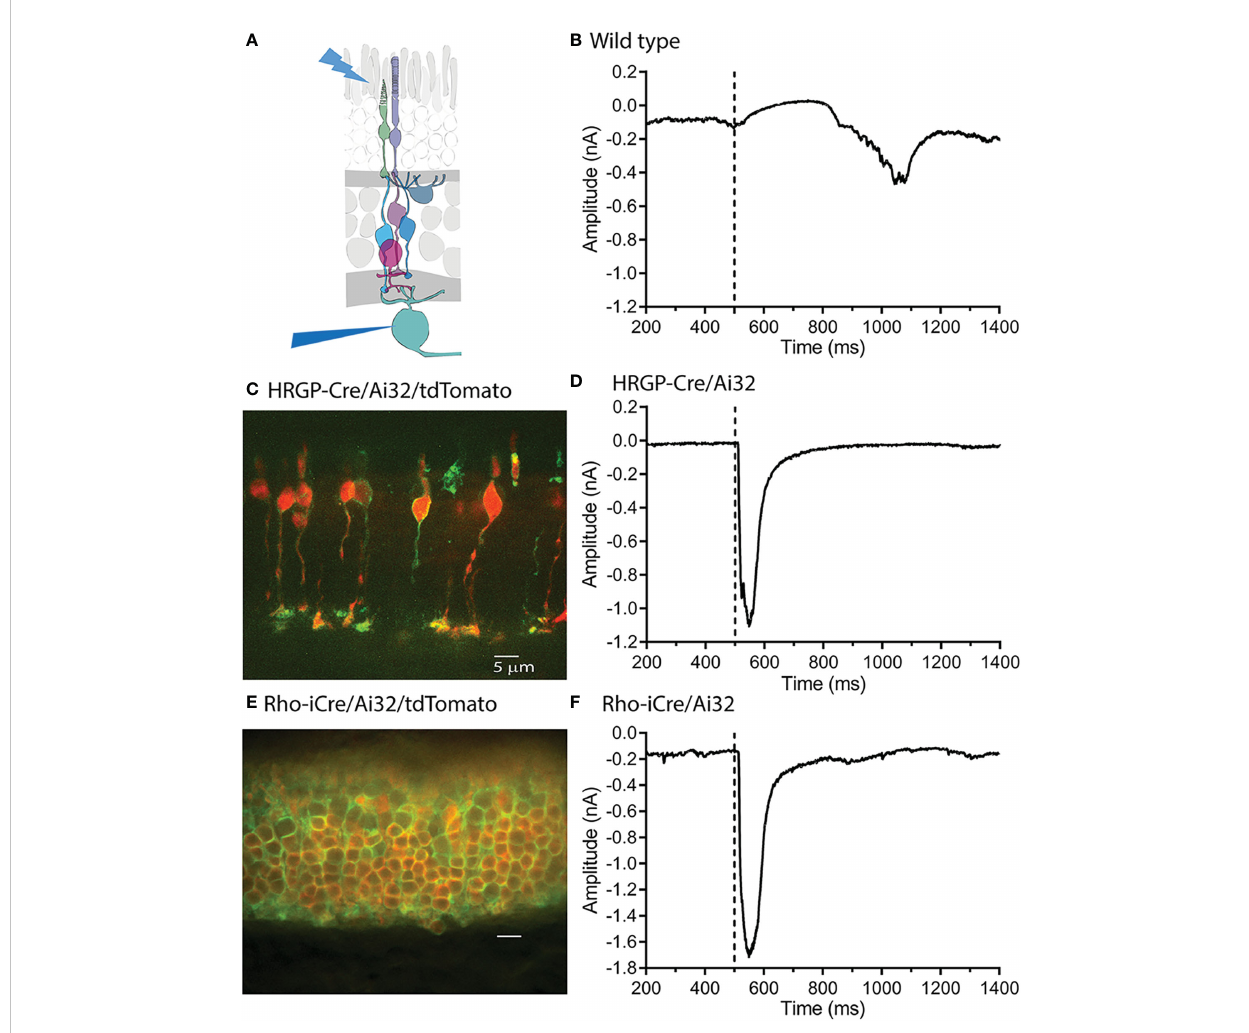
FIGURE 1 Optogenetic stimulation of ChRh2 expressed in rods or cones evoked large fast currents in OFF a ganglion cells. (A) Diagram illustrating the experimental protocol using blue light to stimulate rods and/or cones while recording from retinal ganglion cells. (B) Blue light stimuli evoke slow outward light responses in control C57 mice. These can be readily distinguished from fast inward currents evoked by optogenetic activation of ChRh2. (C) ChRh2 coupled to EYFP labeled cone membranes (green) in this retinal cross-section (maximum intensity projection) from an HRGP- Cre/Ai32 mouse. Cones in this retina were also labeled by Cre-dependent expression of td-Tomato (red). (D) An example of current evoked in an OFF RGC by optogenetic stimulation of cones. (E) EYFP labeled rod membranes (green) and td-Tomato labeled (red) rod cytoplasm in this retinal cross-section (maximum intensity projection) from a Rho-iCre/Ai32 mouse. (F) Current evoked in an OFF RGC by optogenetic stimulation of rods. Experiments in this fi gure were conducted in the presence of strychnine (1 m M) and gabazine (10 m